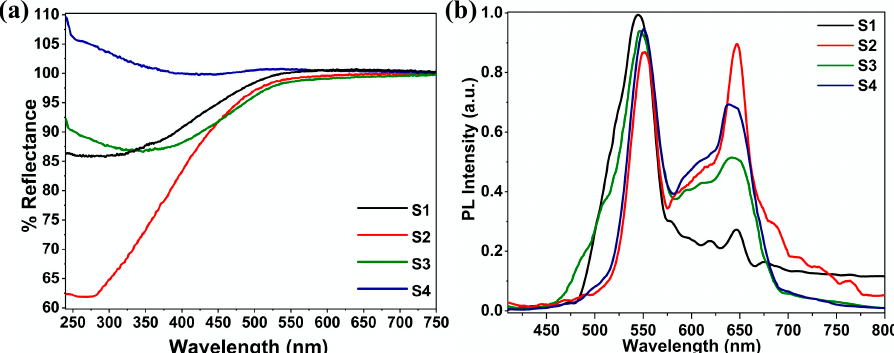
Figure 3. ( a ) DRS and ( b ) photoluminescence spectra of SnS 2 nanoparticles synthesized in the absence and presence of capping agent by thermal decomposition method.